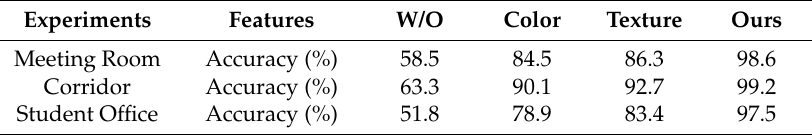
Table 3. Accuracy of DeepNum using different